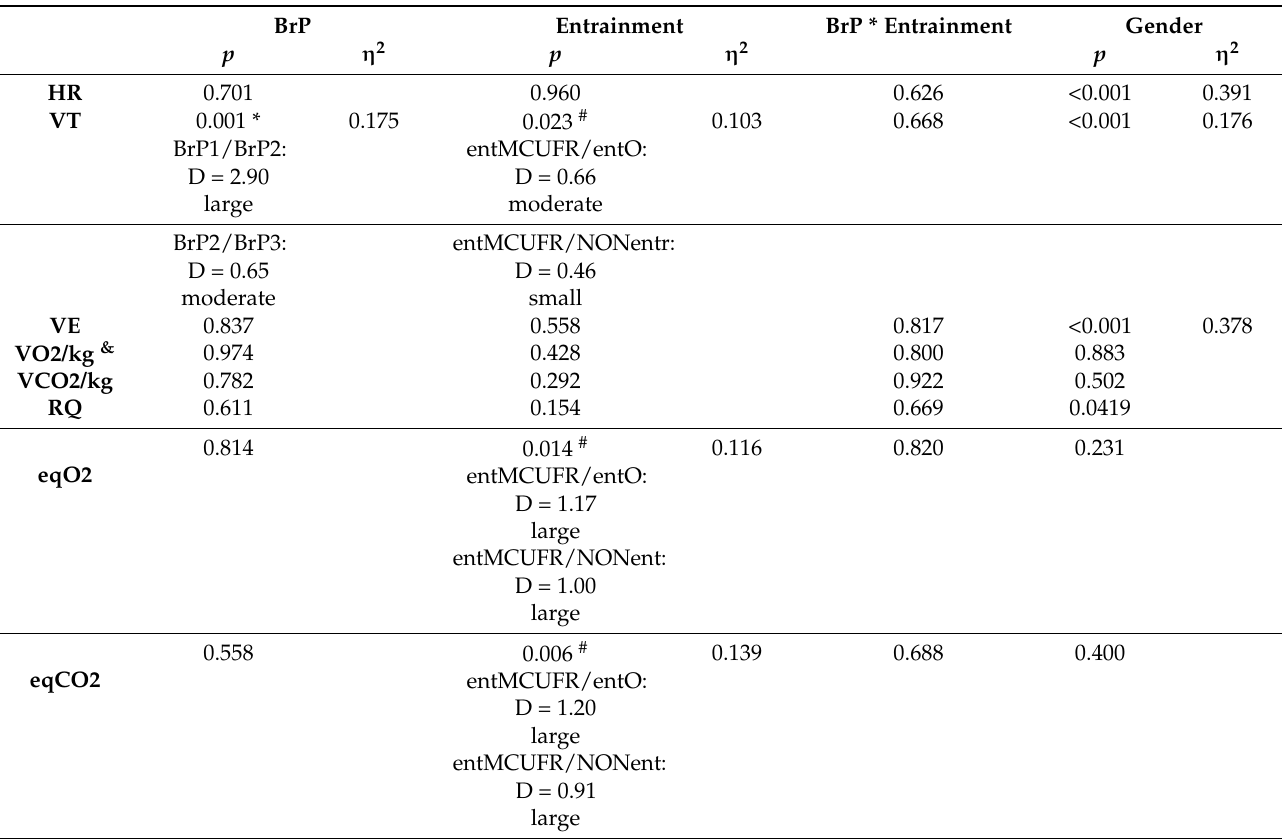
Figure 3. The changes in the measured respiratory and metabolic parameters, which differed significantly regarding either locomotor–respiratory entrainment or the breathing pattern. eqO2 for different entrainment groups ( A ), eqCO2 for different entrainment groups ( B ), VT for different breathing patterns ( C ), VT for different entrainment groups ( D ), RPE for different breathing patterns ( E ) and EPOC for different breathing patterns ( F ). VT—tidal volume; eqO2—ventilatory equivalent for O 2 ; eqCO2—ventilatory equivalent for CO 2 ; RPE—rate of perceived exertion (Borg scale); EPOC—enhanced postexercise oxygen consumption; BrP1,2,3—breathing patterns ; entMCUFR—most commonly used frequency ratio; entO—other entrainments; NONent—not entrained. * Statistically significant differences in the entO and NONent groups versus entMCURF. # Statistically significant differences in BrP1 and BrP3 compared to BrP2. ** Statistically significant differences in BrP2 and BrP3 versus BrP1. Table 1. Statistical parameters of the interaction between the breathing patterns and entrainment with gender as a covariate and the main effects on the measured respiratory and metabolic variables, heart rate, mean arterial blood pressure and RPE during moderate aerobic exercise.